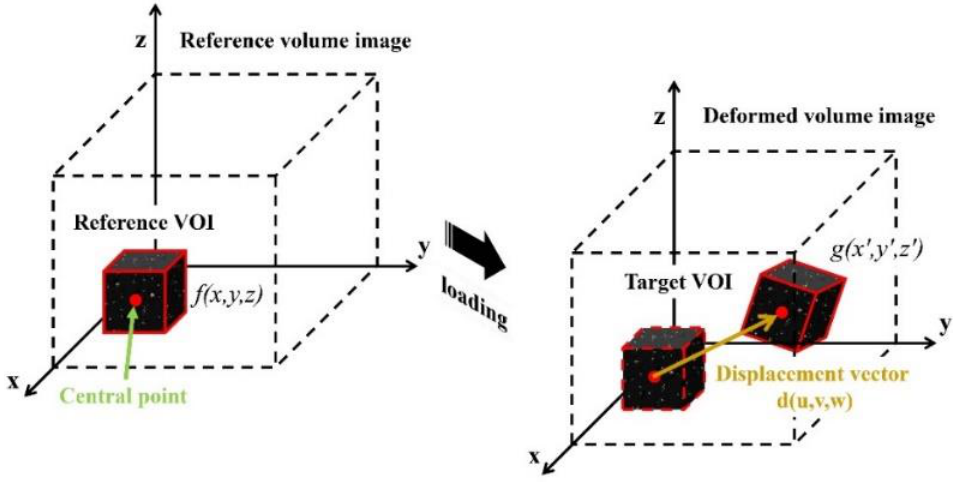
Figure 3. Diagram of finding the displacement by matching the 3D images before and after deformation by DVC.